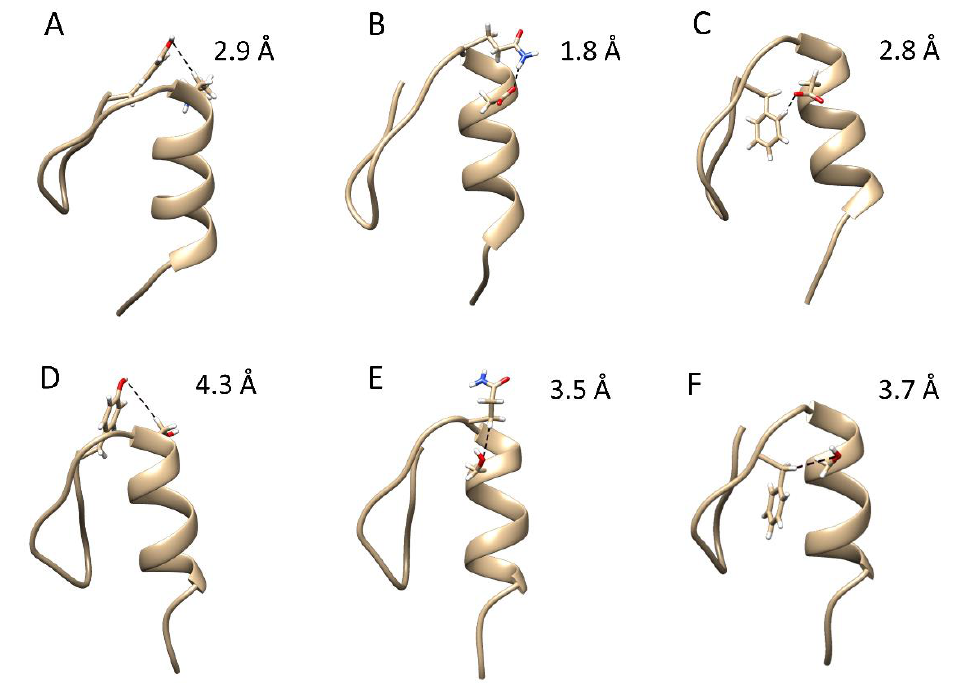
Figure 2. Intermolecular interactions obtained for CP1-1991. These were h-bond Asp15 (S, OD2)- Gln12 (S, HE21) ( A ), h-bond Asp15 (S, OD1)-Phe10 (S, HD2) ( B ), and h-bond Tyr1 (S,OH)-Lys13 (S,HB2) ( C ). As comparison, we have shown the lack of corresponding h-bonds in CP1-2015 ( D – F ). Note Ser15 and Ser13 replace Asp15 and Lys13 in CP-2015. Zn(II) and Zn(II)-binding residues were omitted in the graphics for clarity.